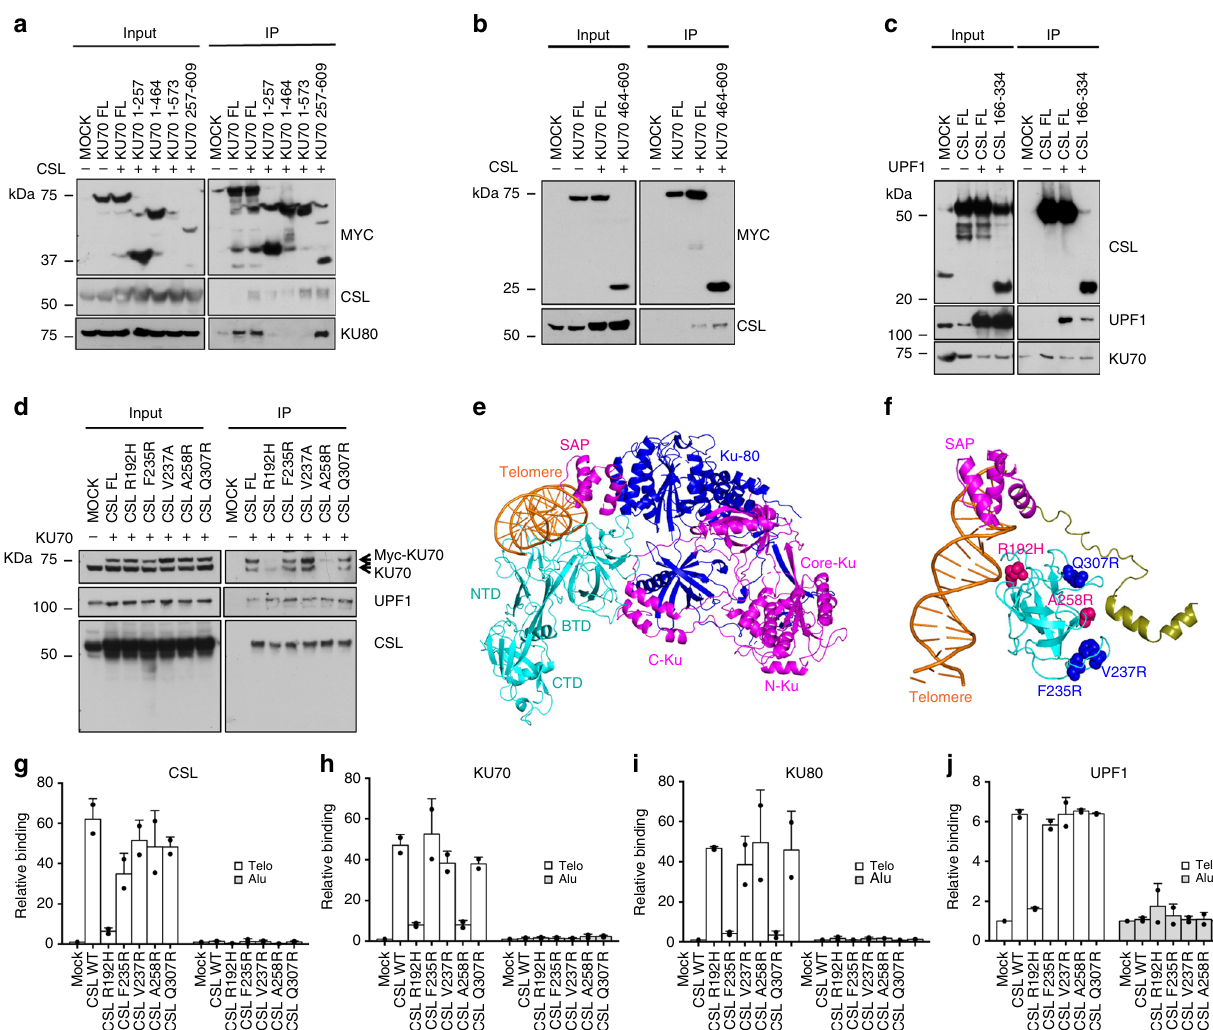
Fig. 8 Mapping, mutagenesis and docking analysis of CSL/UPF1/Ku70/Ku80 interaction. a Co-IP analysis of HEK293T cells expressing MYC-tagged full length (FL) Ku70 and 1-257, 1-464, 1-573, or 257 – 609 domains plus/minus full length (FL) CSL with anti-MYC magnetic beads followed by immunoblotting with antibodies against the indicated proteins. b Co-IP analysis of HEK293T cells expressing MYC-tagged full length (FL) Ku70 or its 464 – 609 domain plus/minus full length (FL) CSL with anti-MYC magnetic beads followed by immunoblotting with antibodies against the indicated proteins. c Co-IP analysis of HEK293T cells expressing FLAG-tagged full length (FL) CSL and CSL BTD (166 – 334) domains plus/minus full length (FL) UPF1 with anti-FLAG magnetic beads followed by immunoblotting with antibodies against the indicated proteins. A second independent experiment is in Supplementary Fig. 9a. d Co-IP analysis of HEK293T cells expressing FLAG-tagged full length (FL) CSL and CSL point mutants (R192H, F235R, V237R, A258R, and Q307R) plus/minus full length (FL) Ku70 with anti-FLAG magnetic beads followed by immunoblotting with antibodies against the indicated proteins. Additional information on CSL point mutants is in Supplementary Fig. 9b. e Cartoon representation showing the docking complex between CSL (cyan) — Telomere DNA (orange) — Ku70 (magenta) and Ku80 (blue) using HDOCK server. Ku70 is shown to interact with CSL-BTD domain and bind to CSL bound telomere DNA through its SAP domain, while Ku80 binds indirectly through Ku70. f Close up view of the docking complex between CSL — Telomere DNA — Ku70 showing the α -helix of C-Ku domain (olive) interacting with CSL-BTD domain (cyan), and Ku70 SAP domain (magenta) interacting with telomere DNA (orange). The “ hot spot ” mutations that abrogate CSL-Ku70 interaction and Ku70-telomeric DNA association as in d are shown in pink (A258R and R192H). Additional non-interfering mutations are labeled in blue (F235R, V237R, and Q307R). g – j Telomeric binding assays with antibodies against the indicated proteins followed by qPCR with telomere- and alu-speci fi c primers in HEK293T cells expressing CSL full length (WT) and point mutants (R192H, F235R, V237R, A258R, and Q307R). Non-immune IgGs were used for normalization. Bars represent mean ±